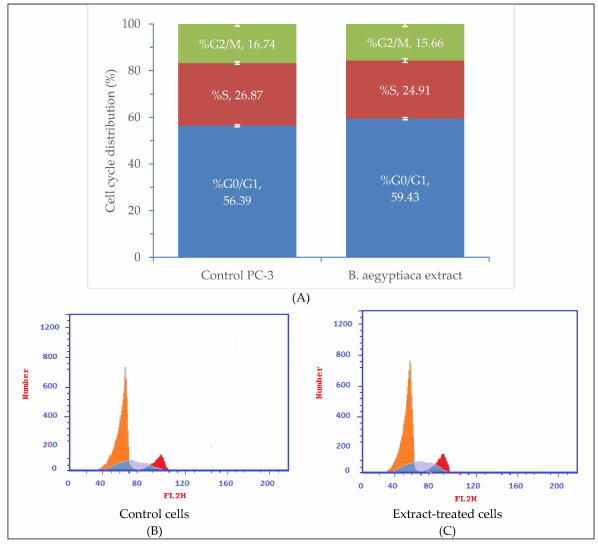
Figure 7. Flow cytometry results of cell cycle distribution of PC-3 cells subjected to B. aegyptiaca methanolic fruit extract at 92 µ g/mL: ( A ) quantitative cell cycle distribution %. The data presented are the means ( n = 3) ± SD indicated by the vertical bars. ( B ) DNA content of control cells; ( C ) DNA content of extract-treated cells. Flow cytometry histograms were derived from annexin V-FITC staining assay for PC-3 cells after 24 h incubation in medium alone ( A ) or medium plus B. aegyptiaca methanolic fruit extract at 92 µ g/mL ( B